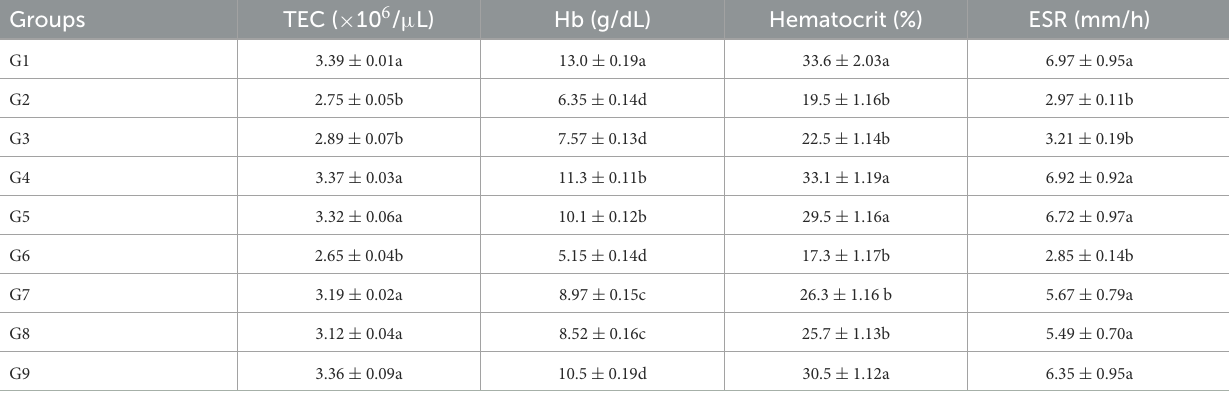
TABLE 2 Hematological parameters including total erythrocyte counts, hemoglobin concentration, hematocrit, and erythrocyte sedimentation rate on day 21 experiment in broiler chicks administered arsenic, chromium, vitamin E, and bentonite alone or in combination. Groups